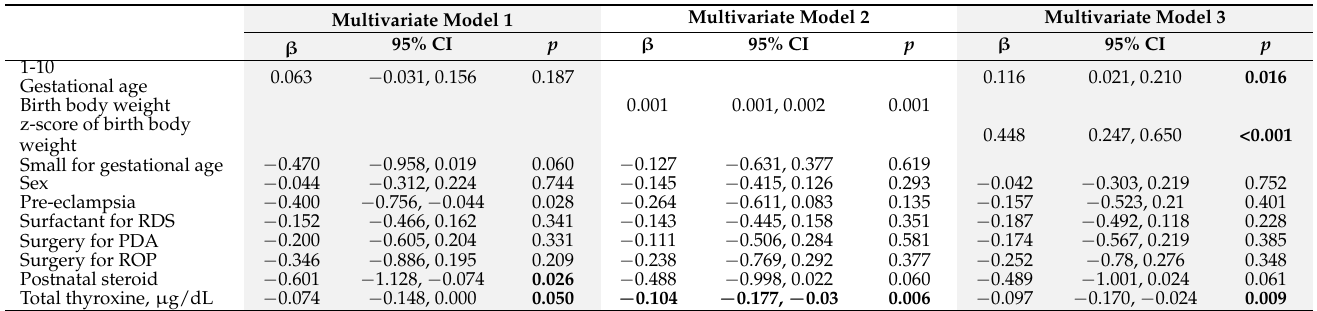
Table 3. Primary outcome: the dependence of body mass index z-scores at 24 months old on clinical variables (multivariate analyses).